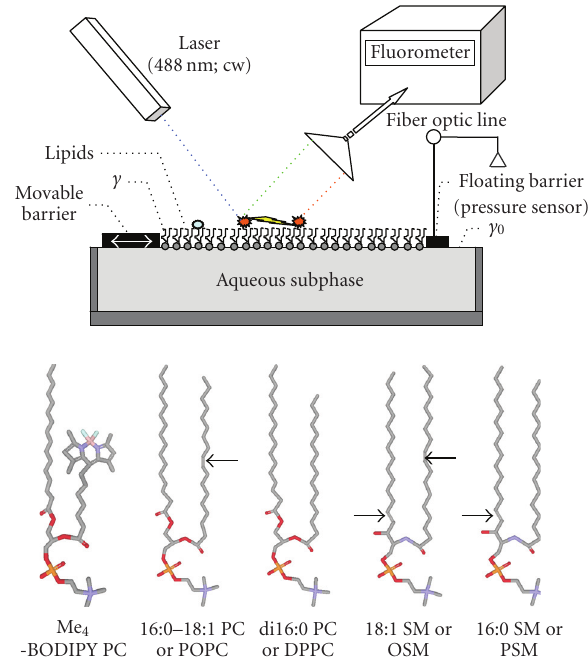
Figure 1: Experimental set-up and structures of lipids investigated. Upper panel depicts a Langmuir surface balance modified to acquire fluorescence emission spectra of lipids forming a monolayer at the air/water interface. γ 0 = surface tension of gas/water interface; γ = surface tension of gas/water interface covered by lipid; ( γ = surface pressure. Lower panel shows the structures of the lipids studied. The following color scheme applies: gray = carbon, red = oxygen, blue = nitrogen, orange = phosphorus, pink = boron, aqua = fluorine. Arrows pointing left indicate cis double bonds and arrows pointing right equal trans double